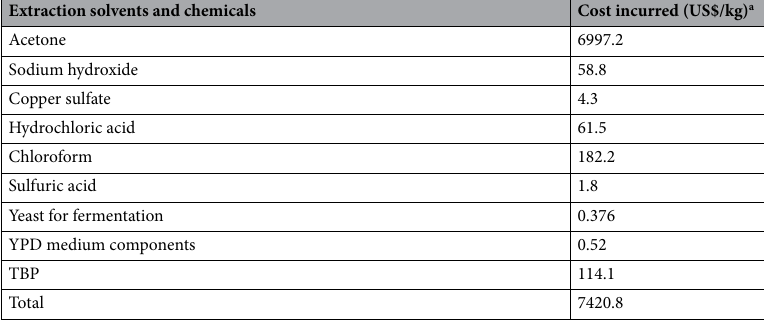
Table 10. Cost estimation of chemicals and solvents required for harnessing the cyanobacterial products using the sequential biorefinery design, utilizing APL medium. a Cost was evaluated considering per kg of dry biomass obtained using the APL medium, based on the price of bulk chemicals from http:// www. aliba ba.